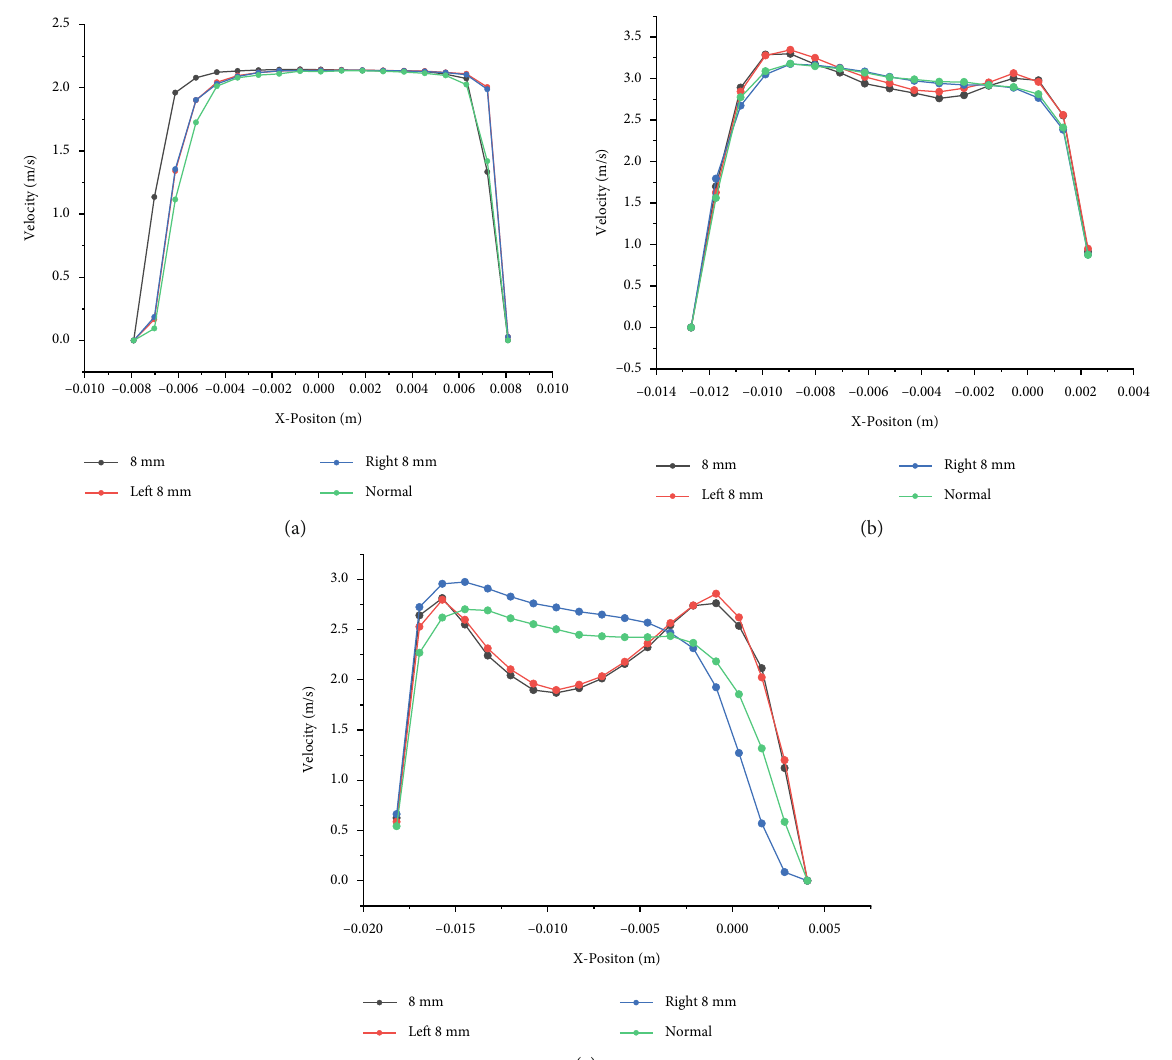
Figure 9: Velocity pro fi les for the healthy airway and foreign bodies of di ff erent locations, at (a) line1, (b) line2, (c)